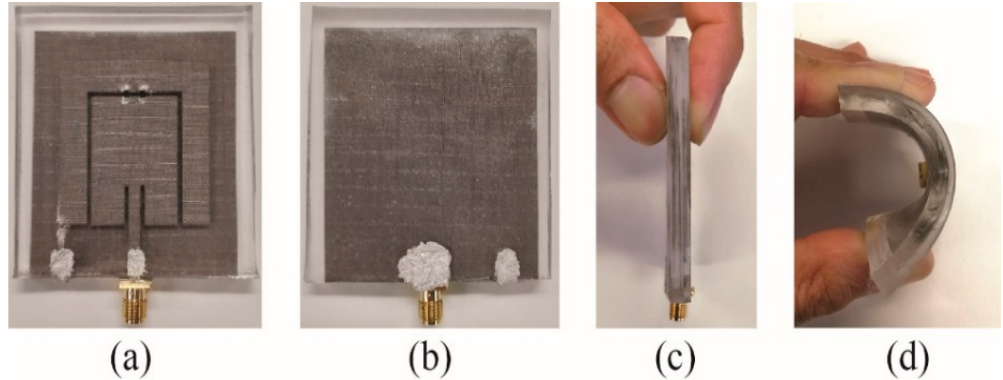
Figure 2. The fabricated frequency-reconfigurable antenna on polydimethylsiloxane (PDMS) substrate in [24]: ( a ) front view; ( b ) back view; ( c ) side view; ( d ) bending position .